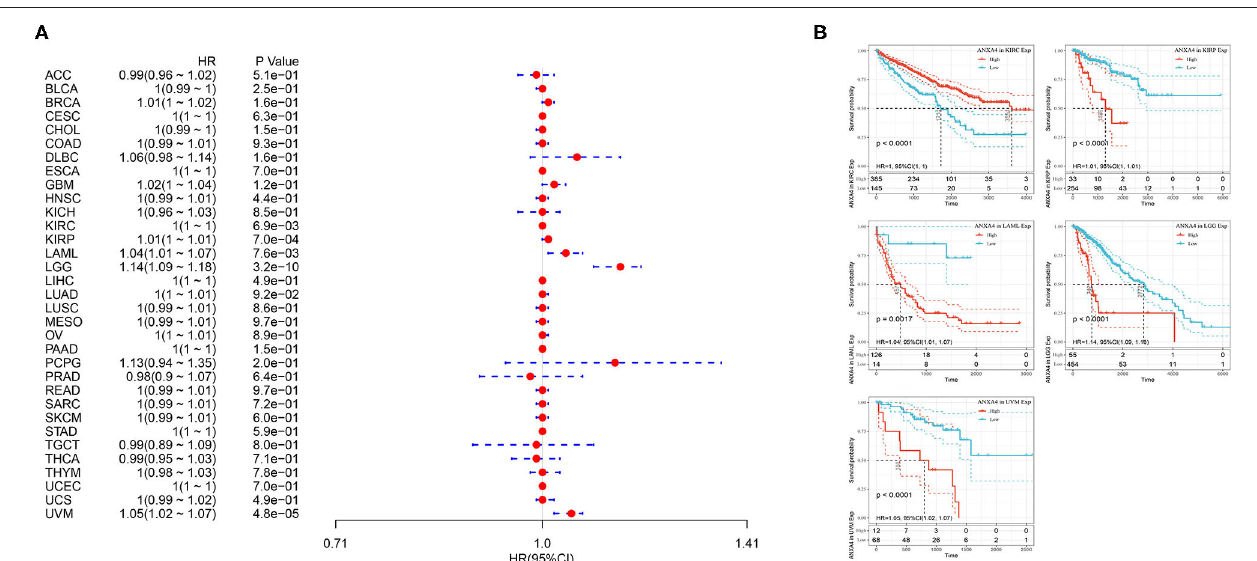
FIGURE 5 | Relationships between ANXA4 expression levels and prognosis. (A) Forest plots of overall survival (OS). (B) Kaplan-Meier curves for